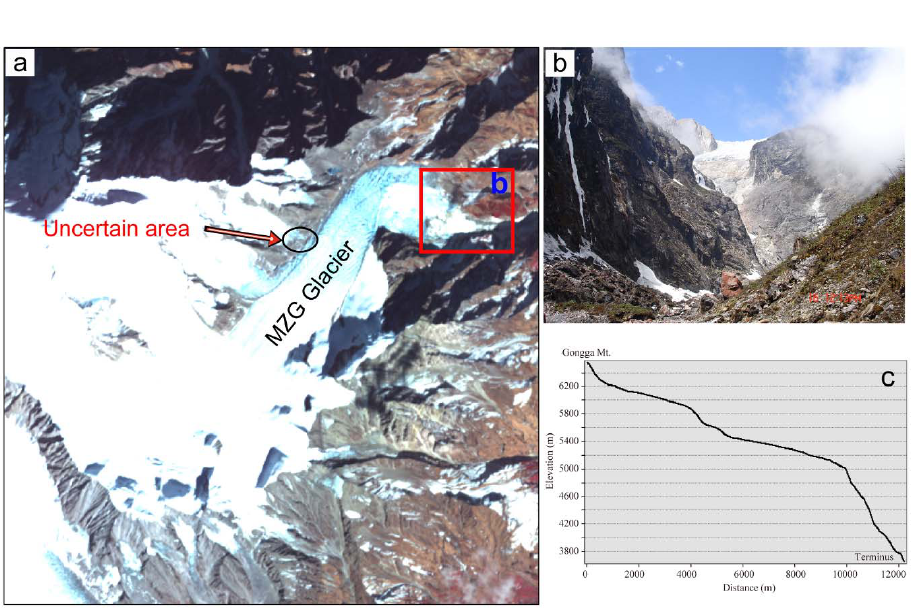
Fig. 5. (a) ASTER image showing the MZG Glacier in 2009. (b) Field photo showing the terminus of the MZG Glacier in 2009. (c) The longitudinal profile of the MZG Glacier from the 1989 DEM.